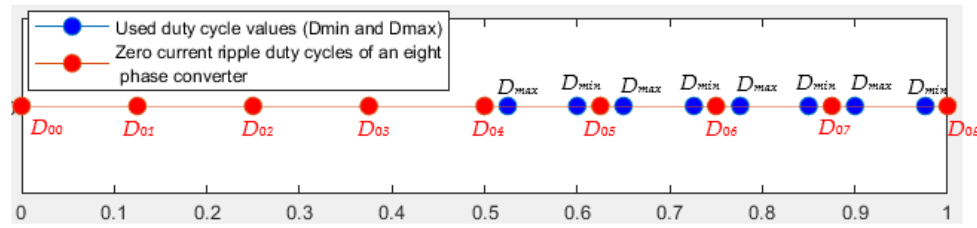
Figure 42. Minimum and maximum duty cycles of permissible duty cycle regions of an eight-phase converter.